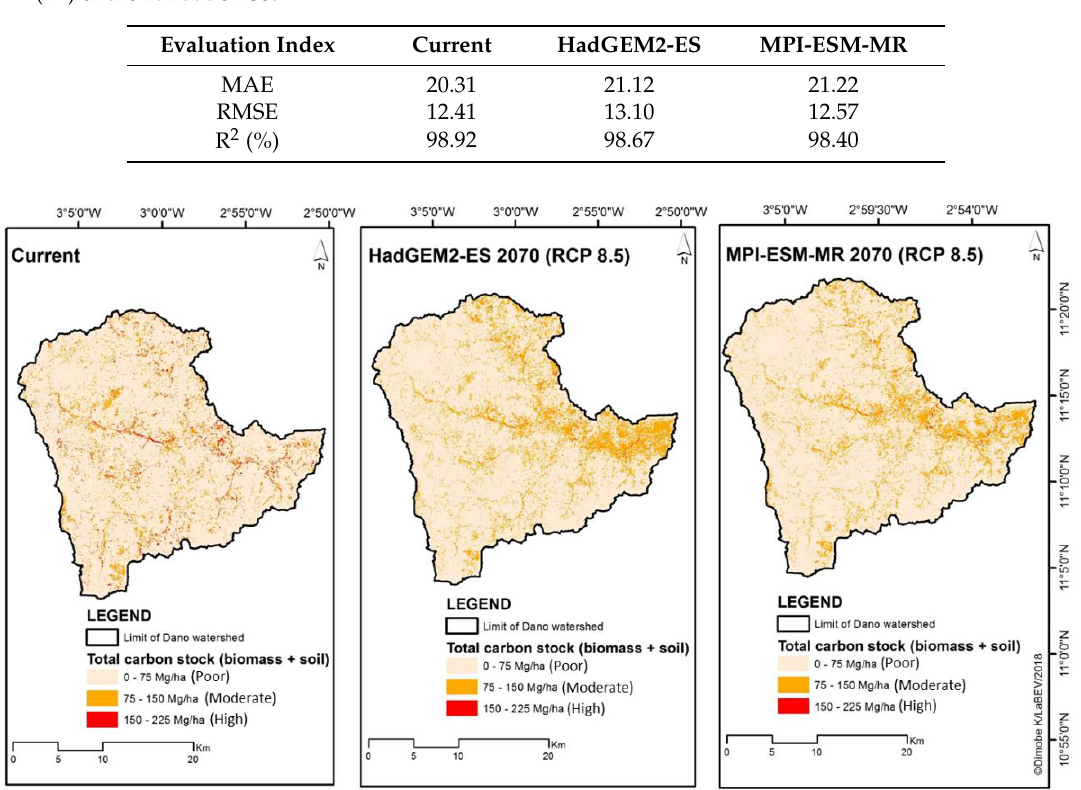
Table 6. Mean Absolute Error (MAE), Root-Mean-Squared Error (RMSE), and coefficient of variation (R 2 ) of the validation set.